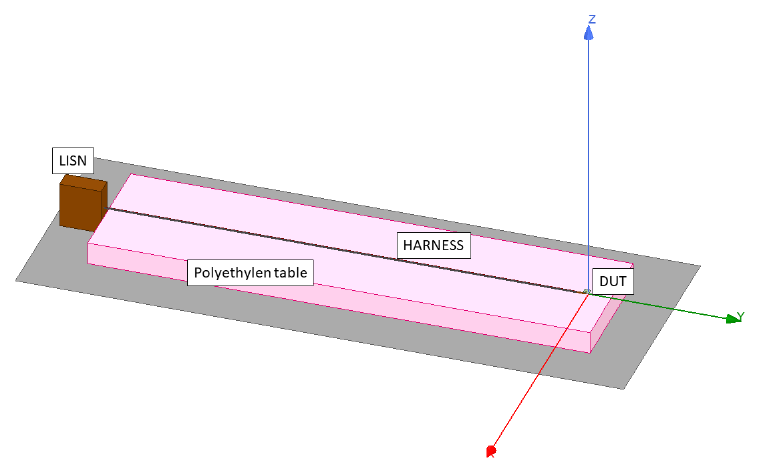
Figure 7. Modeled test setup according to the CISPR 16-2-1.